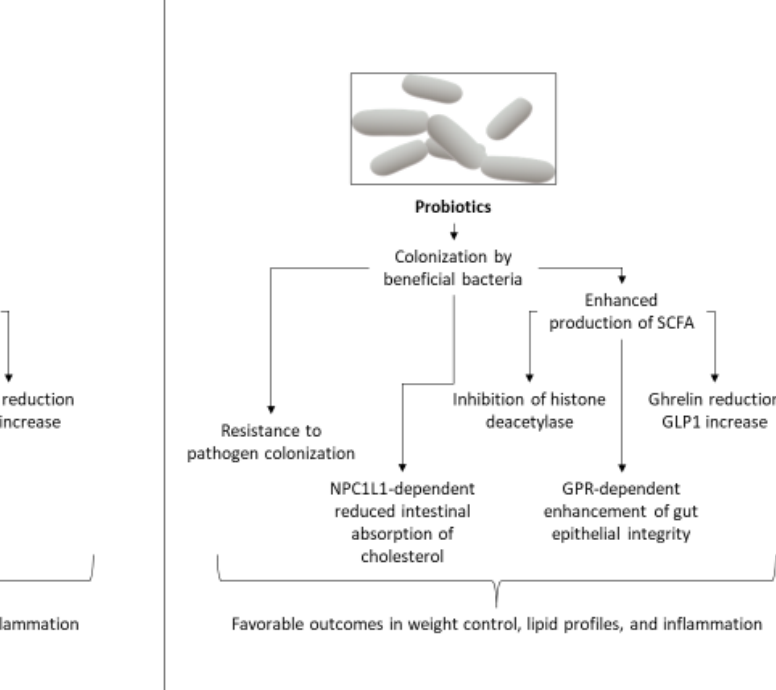
Figure 3. Examples of cellular and molecular mechanisms underlying the potential effects of pre- and probiotic administration in metabolic and coronary artery disease. GLP1: glucagon-like peptide-1, GPR: G-protein coupled receptor, NPC1L1: Niemann-Pick C1-like 1 protein, SCFA: short-chain fatty acids.